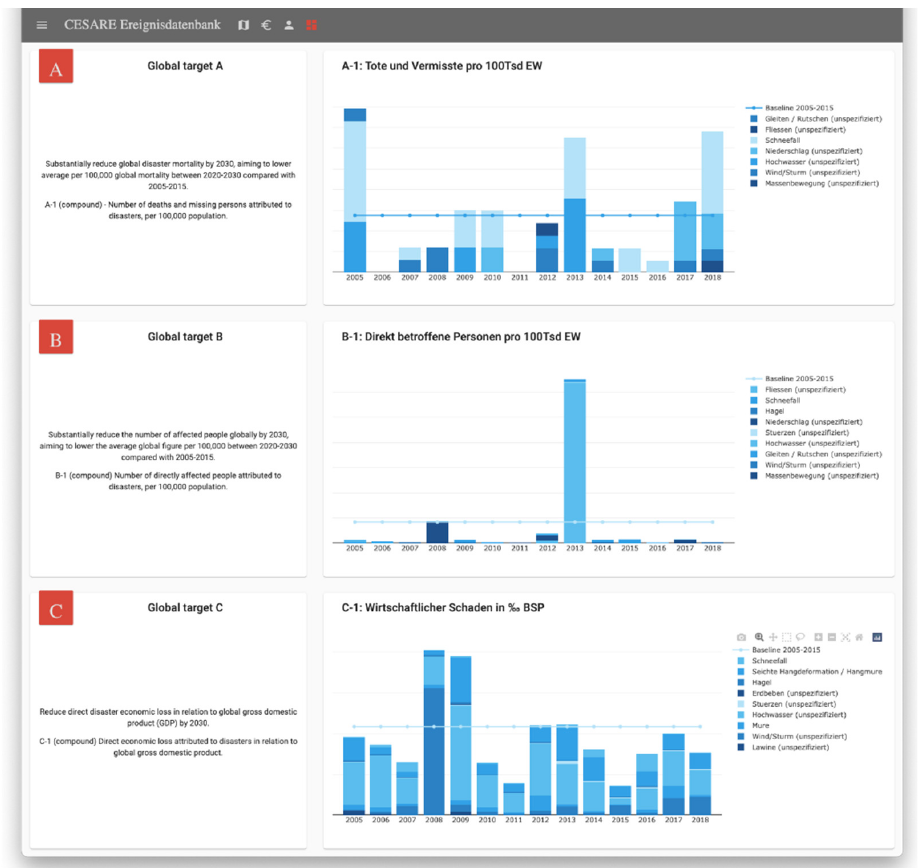
Figure 9. Snapshot of the CESARE demonstrator dashboard service for Sendai monitoring global targets ( A – C ).